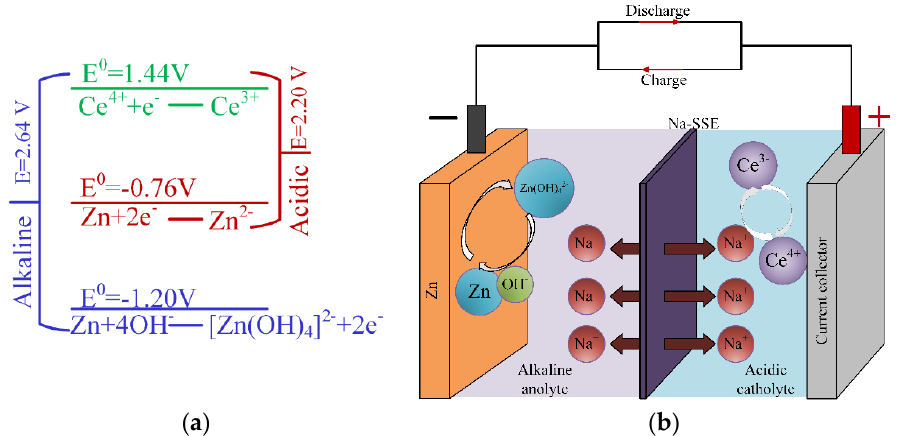
Figure 53. ( a ) Schematic illustration of the theoretical voltages of Zn-Ce batteries with an alkaline or acidic anolyte; ( b ) schematic of a Zn-Ce battery with an alkaline anolyte, an acidic catholyte, and a Na+-ion solid electrolyte (termed as Zn(NaOH) ǁ Na-SSE ǁ Ce4+(MSA/Na2SO4) cell) [159].